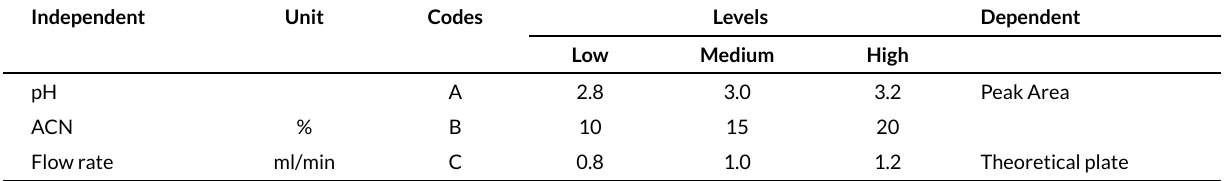
Table 1. Optimized Box-Behnken experimental design with independent with dependent